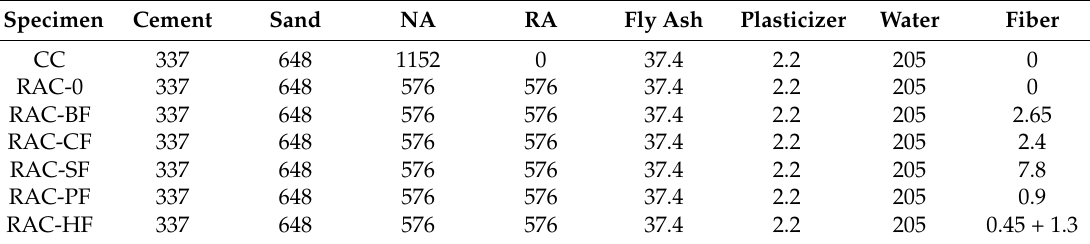
Table 3. Mix proportion of different fiber-reinforced RAC (kg/m 3 ).